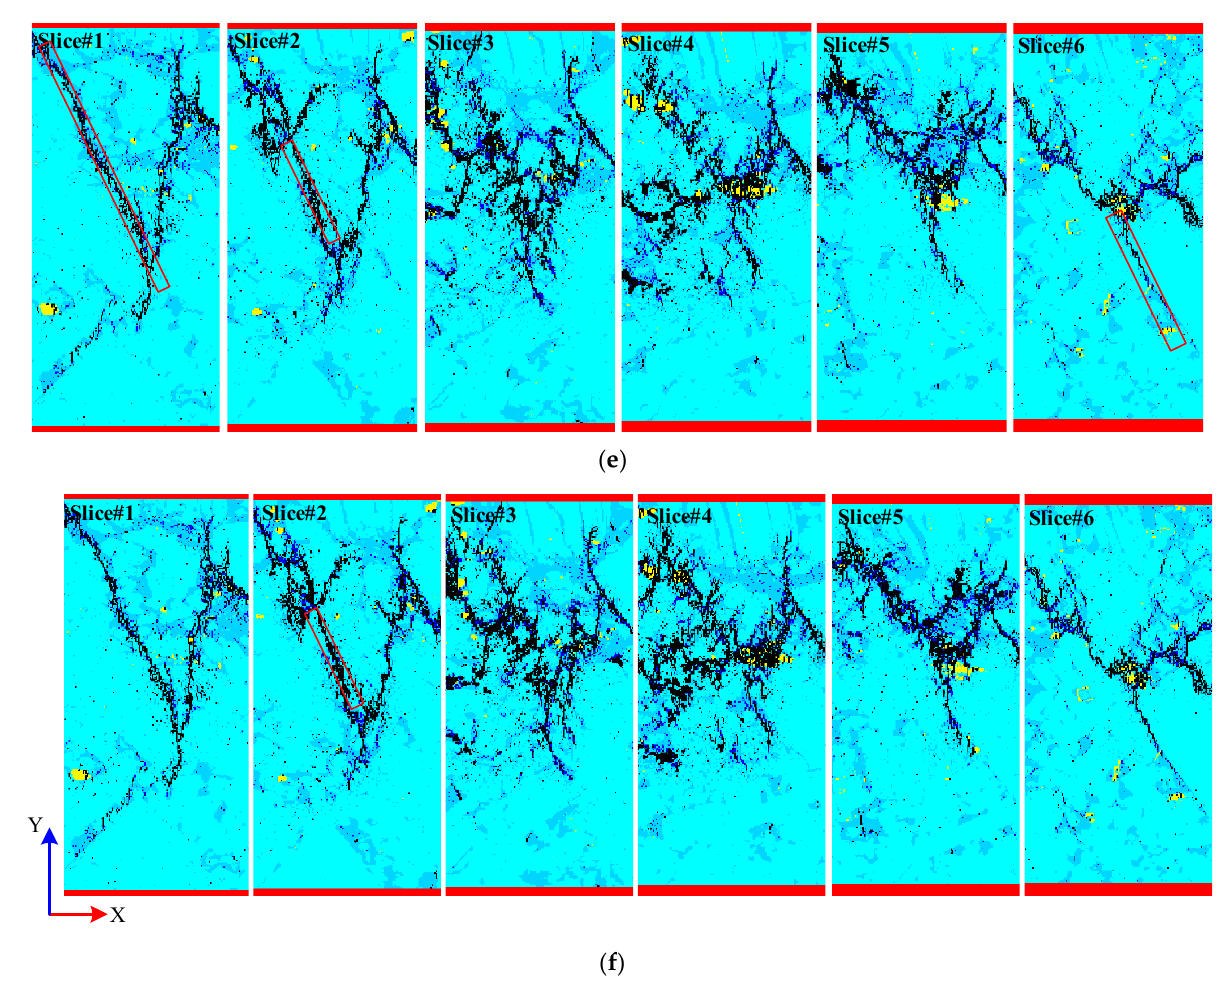
Figure 7. Internal fracture evolution in micro shale sample sliced along different Z planes. ( a – f ) The slices at different loading stages, corresponding to points A–F in Figure 6g, respectively. ( organic matter, carbonate minerals, pyrites, damage elements, fractures).